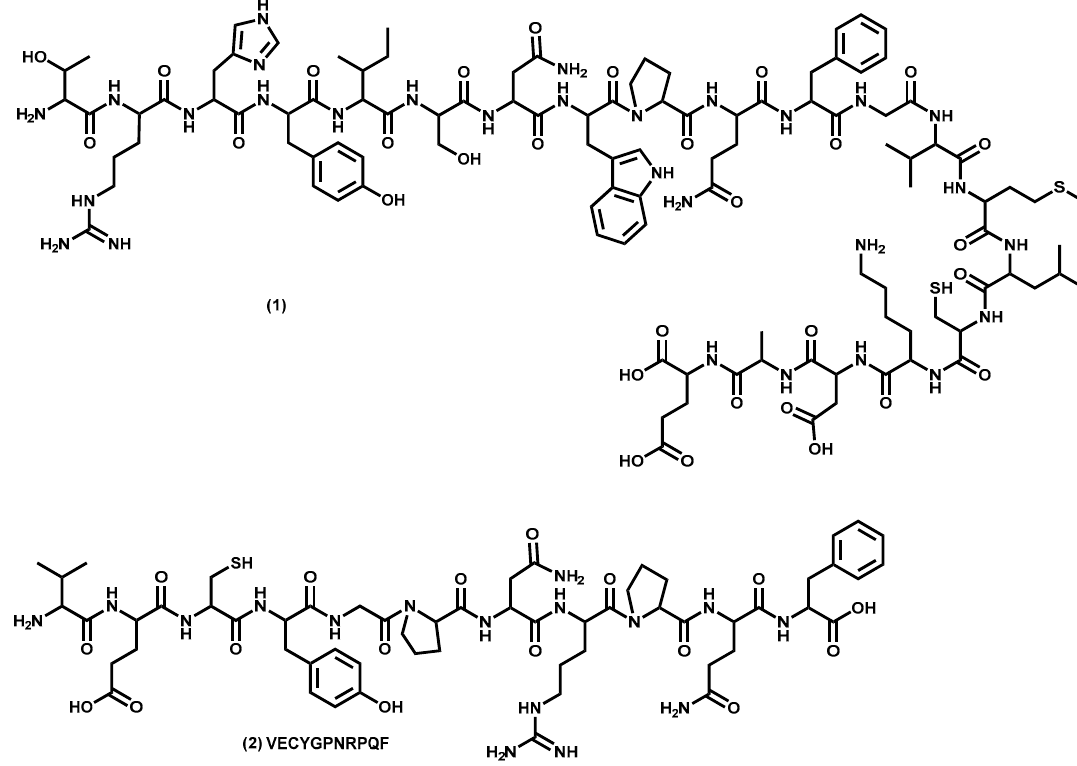
Figure 1. Primary structure of a hypothetical protein consisting of all amino acids ( 1 ) and the seaweed peptide with potent antioxidant activity ( 2 ).